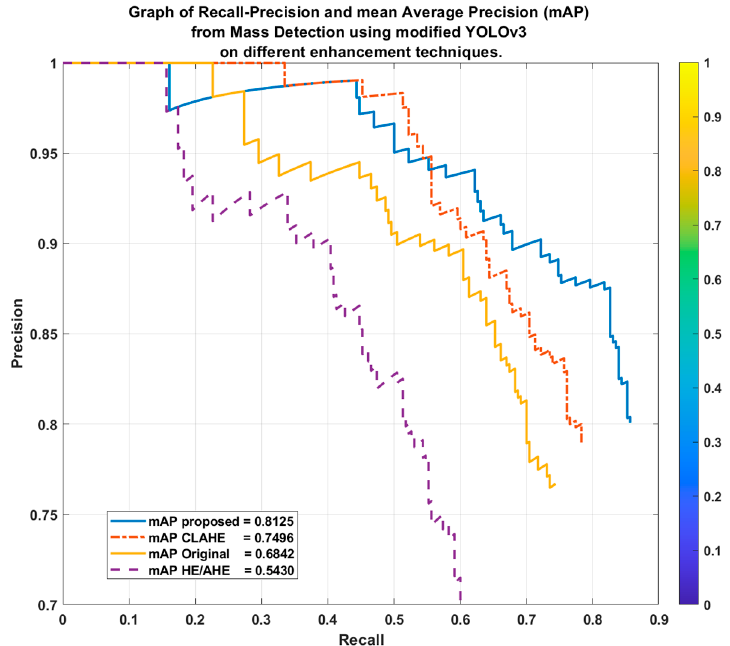
Figure 8. Graph of Recall-Precision Curves and mean Average Precision (mAP) from Mass Detec- tion using modified YOLOv3 on different enhancement